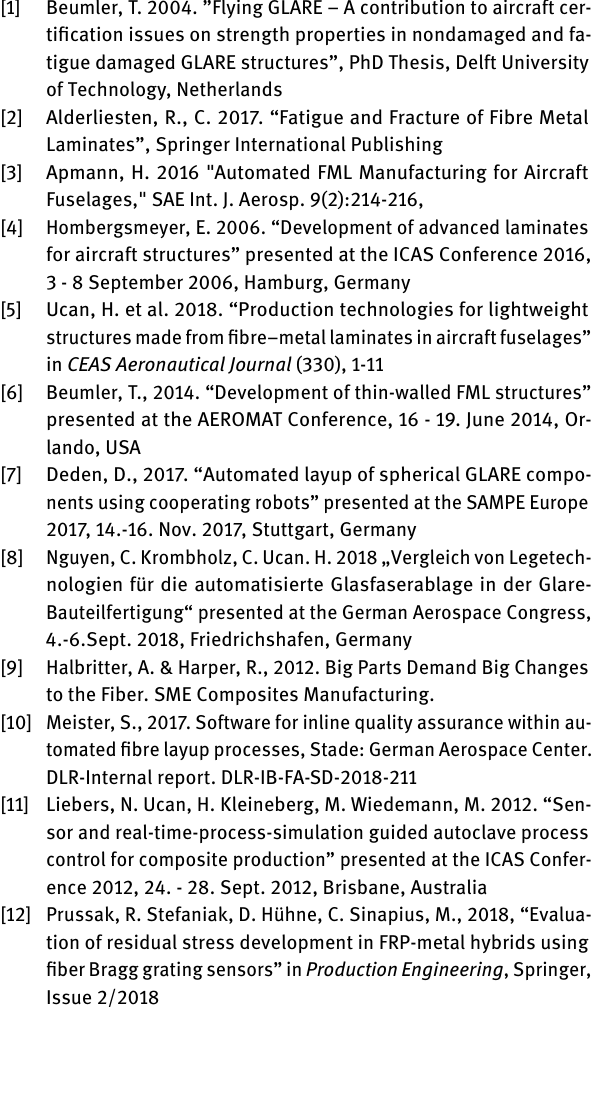
Figure 8: In-situ strain measurement using FBG and strain gages during autoclave processing